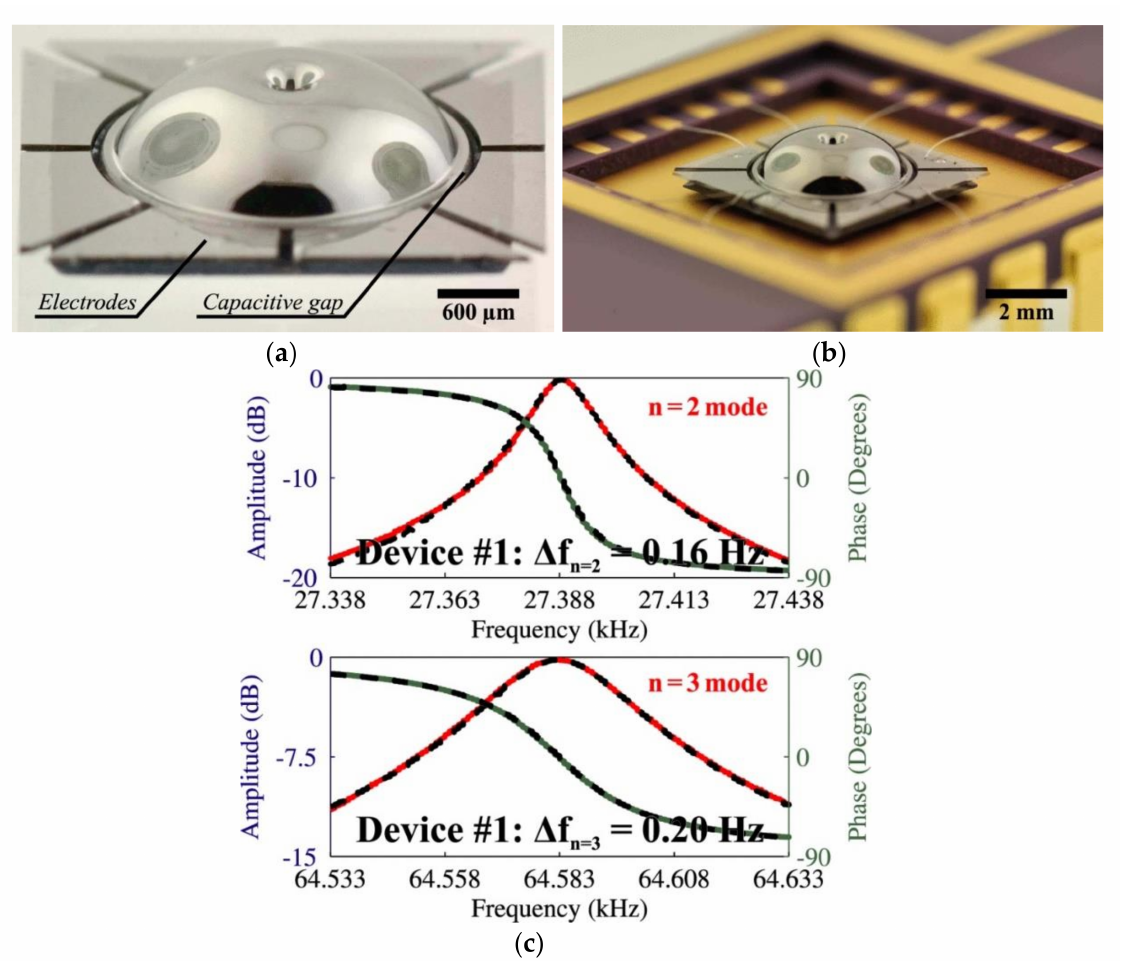
Figure 8. Metallized micro-wineglass structure with integrated electrodes, diameter 4 mm, thickness 50 µ m, and its performance (Senkel et al. [90]) © 2022 IEEE. Reprinted, with permission from IEEE from D. Senkal, M. J. Ahamed, A. A. Trusov and A. M. Shkel, “Achieving sub-Hz frequency symmetry in micro-glassblown wineglass resonators”, Journal of Microelectromechanical Systems, vol. 23, no. 1, pp. 30–38, 2014. ( a ) Picture shwoing metallized micro-wineglass structure with integrated electrodes, ( b ) Picture showing packaged and wirebonded device, ( c ) Experimental frequency sweeps of n = 2 and n = 3 wineglass